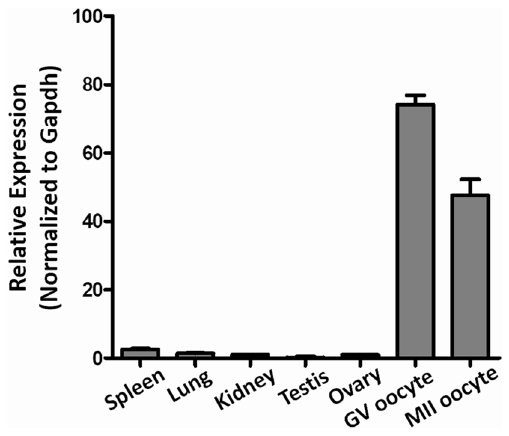
Figure 1. The mRNA expression of Tmem150b in mouse tissues and oocytes detected by qRT-PCR. The expression level of this gene in the ovary was set as “1” and other samples were normalized to